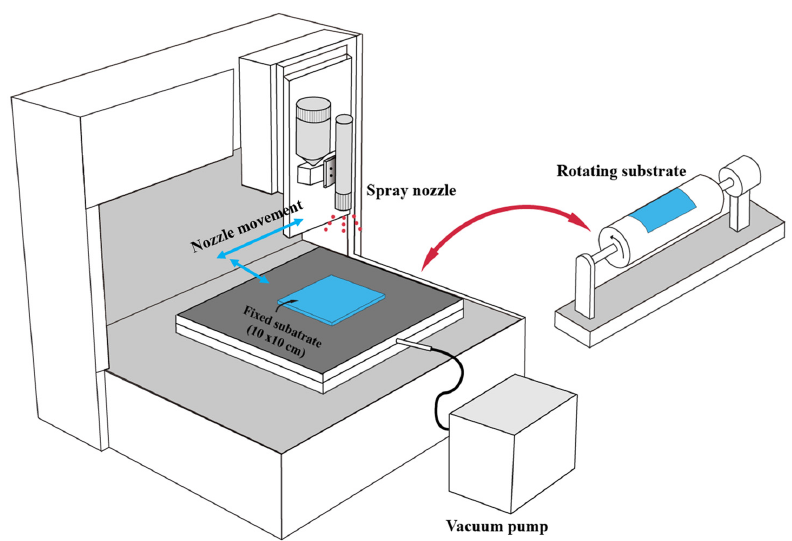
Figure 2. Spray coater machine with an air pulse dispenser type.